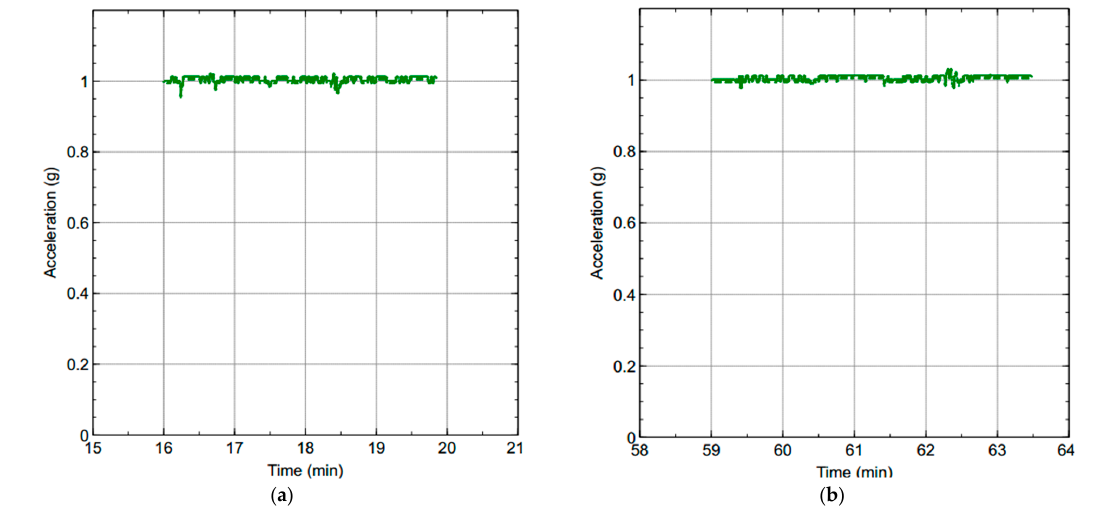
Figure 12. Estimated acceleration obtained from local Kalman filter implementation: ( a ) Node 00; ( b ) Node 01.